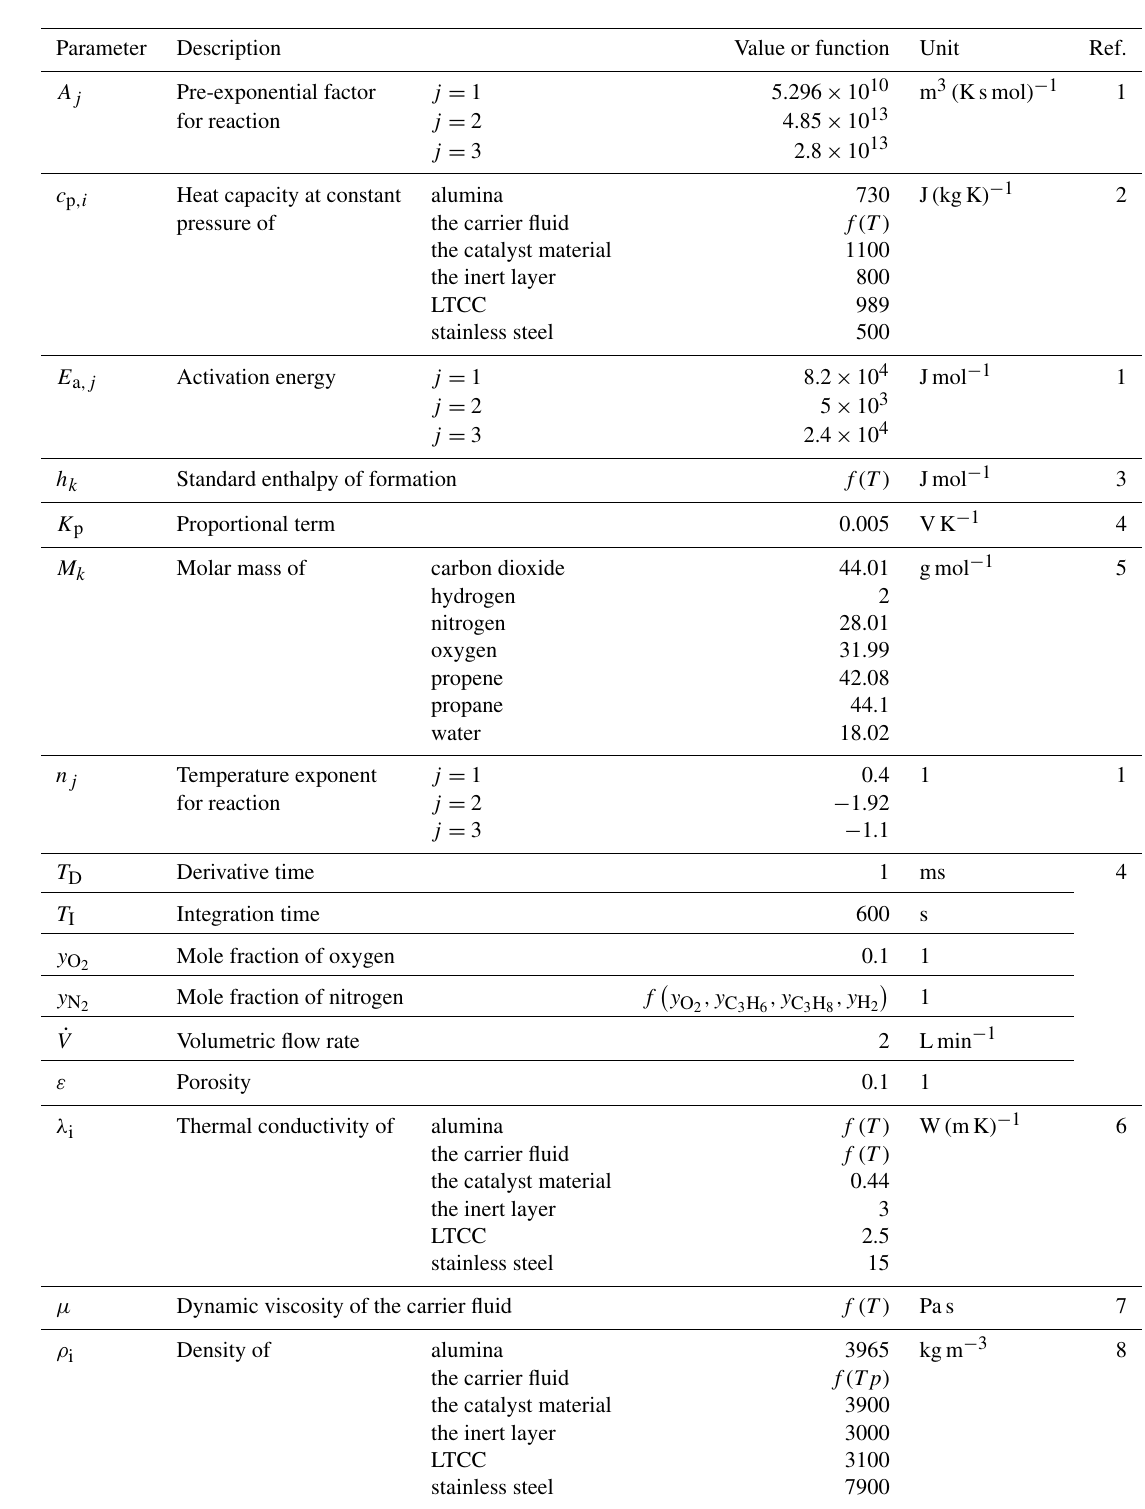
Table 1. Parameters used for modeling of the sensing principle.